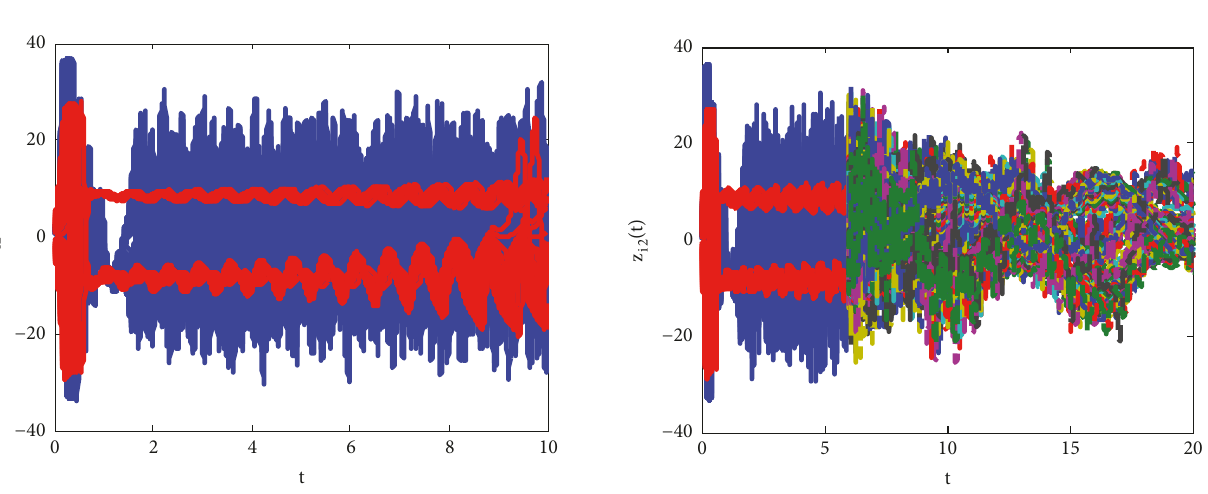
Figure 6: (Color online) Evolution curves of state variables 𝑧 𝑖2 (𝑡) after adding control.